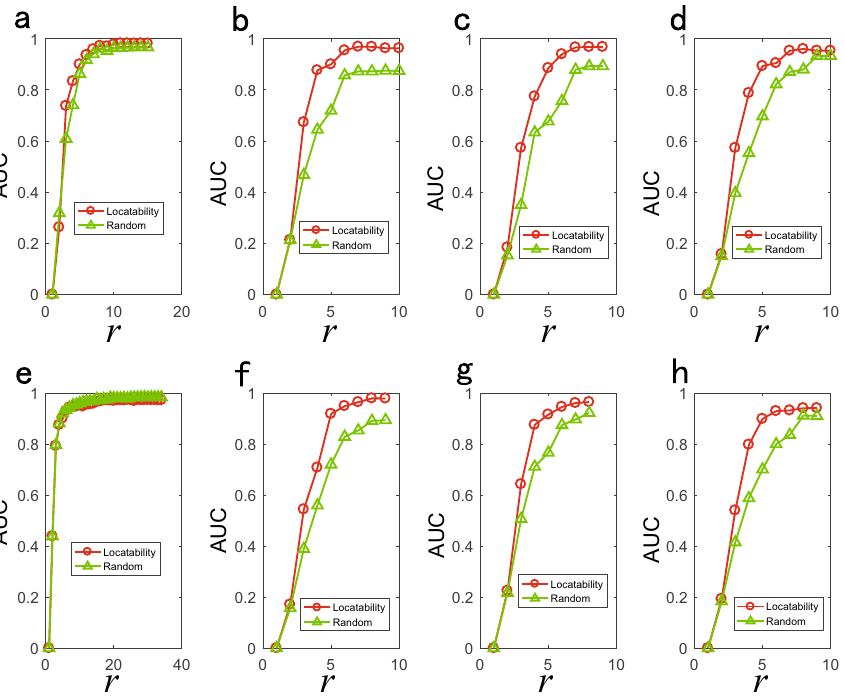
Figure 10. Locating source results of locatability and random strategy of diffusion dynamics on model networks. Abscissa is the number of observer nodes r and ordinate is AUC value. We simulate diffusion epidemic on model network with 50 nodes. We set u = 2 and σ = 0.25 for the time delay distribution and two sources. ( a )–( d ) are the results of BA networks and correspond to network average degree � k � = 2, 4, 6 and 8 respectively. ( e )–( h ) are the results of ER networks and correspond to adding link probabilities 0.05, 0.25, 0.45 and 0.65